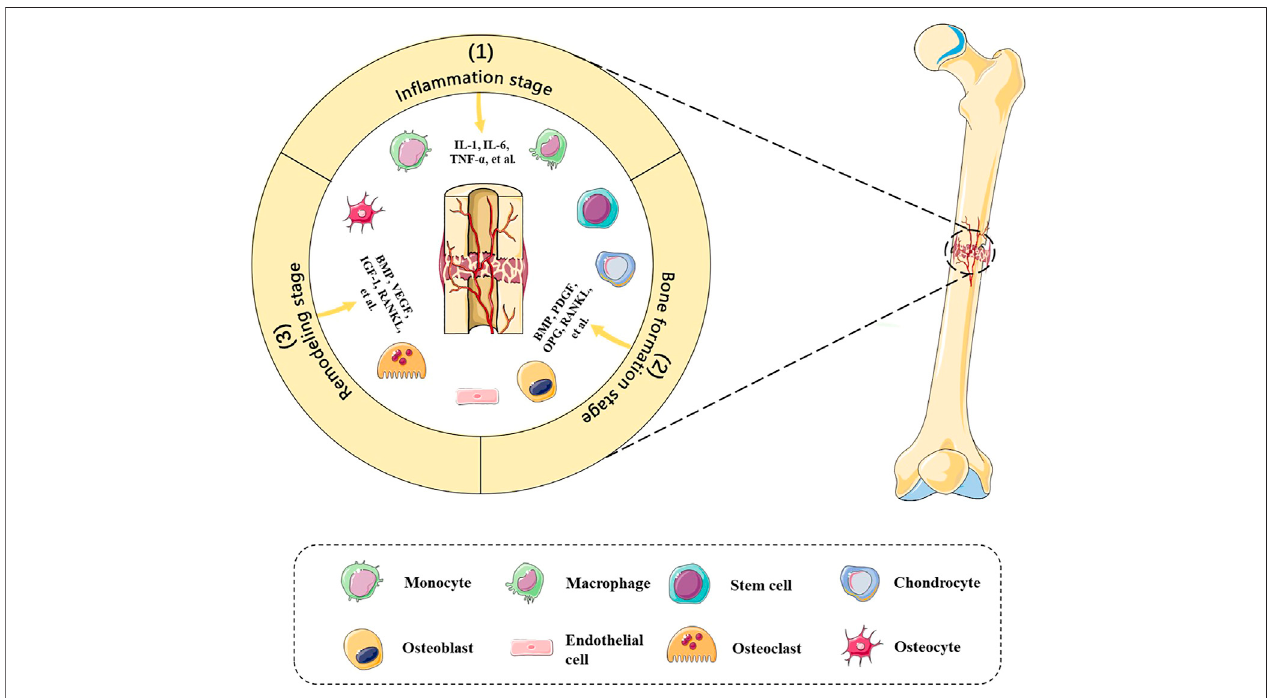
FIGURE 1 | Bone defect microenvironment. Dynamic composition and cross-interactions of various cells and molecules are involved in the bone defect microenvironment. Thebone healingstagesinclude1) in fl ammation stage, 2)boneformationstage,and 3)remodeling stage, whichentailsimmunecells, chondrocytes, stem cells, osteoblasts, etc., and RANKL, PDGF, BMPs, TNF- α , etc., in a spatiotemporal manner.